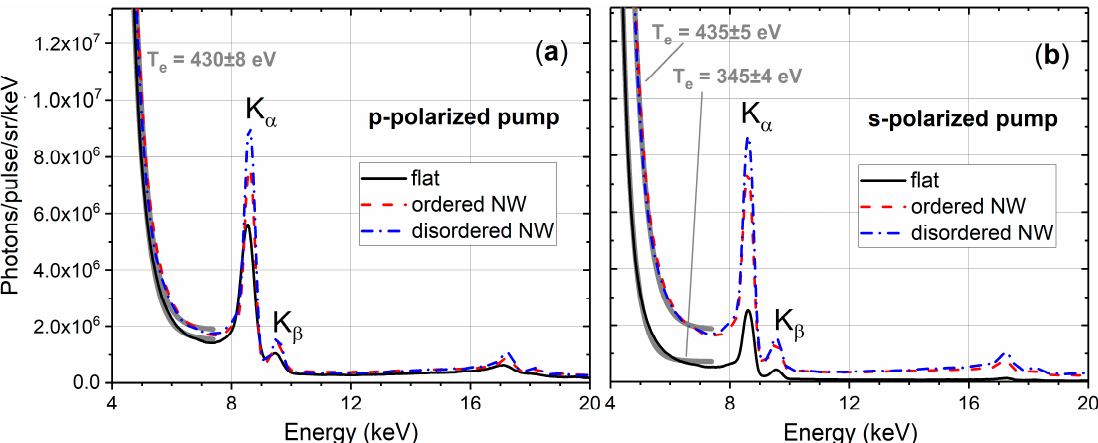
Figure 4. X-ray spectra from the flat (solid black line) and nanostructured (ordered NW (dashed red line) and disordered NW (dash-dotted blue line)) ZnO targets for p-polarization ( a ) and s-polarization ( b ) measured by CCD1 in single photon counting regime. The spectra were fitted with an exponential function (solid grey line), providing an estimation of the electron bulk temperature T e .